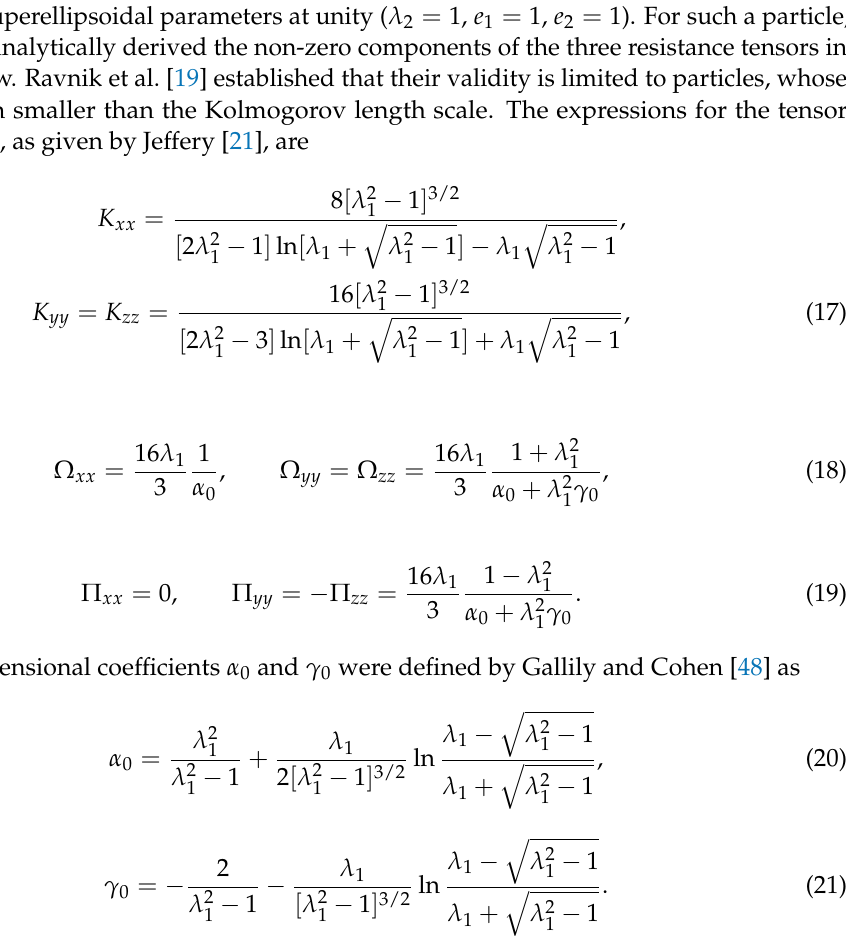
Figure 3. Boundary traction magnitude || (cid:126) q || the uniform flow ( left ), rotational flow ( centre ) and the shear flow ( right